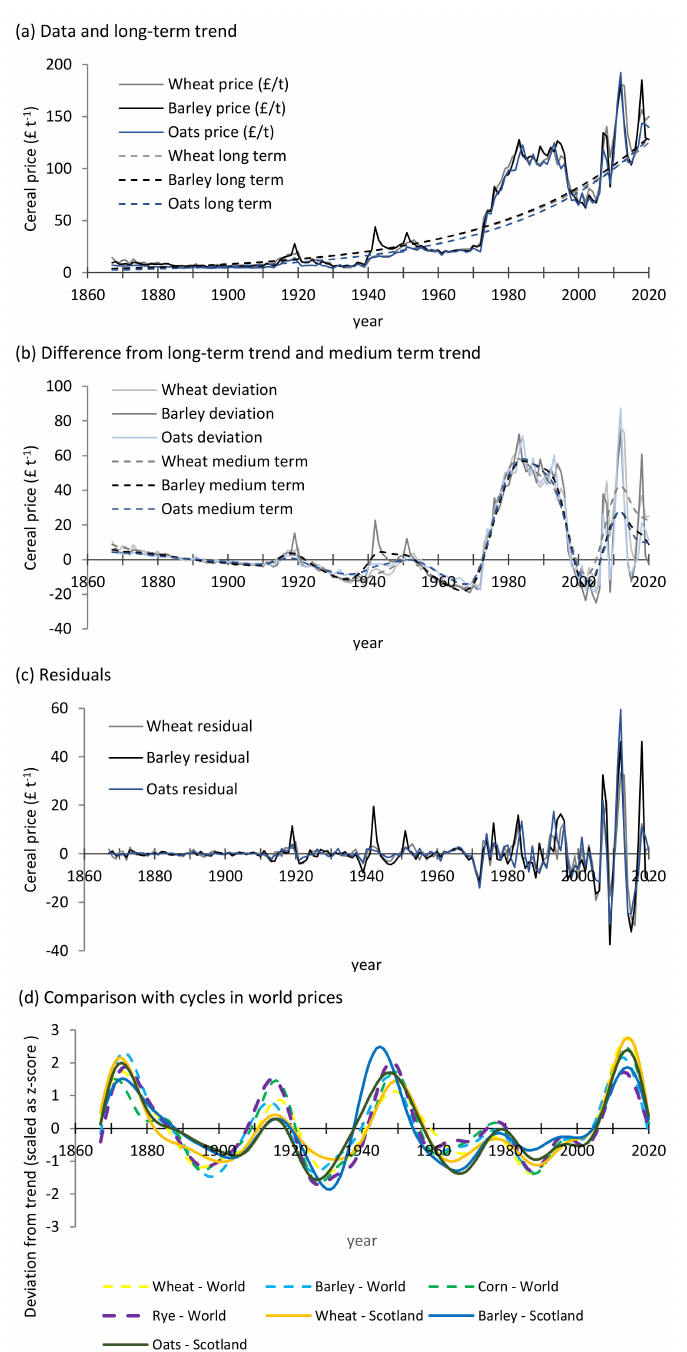
Figure 2. Long-, medium-, and short-term variation in prices for wheat, barley, and oats in Scotland (1867–2020). ( a ) data and long-term trends, ( b ) deviations from the long-term trend and smoothing spline model, ( c ) residuals after removal of the long- and medium-term trends. ( d ) comparison of cycles for prices of wheat, barley, and oats in Scotland with grain crops (wheat, barley, corn, and rye) in world data from Jacks [37,83]. Note: the prices shown in Figure 2a,b, and c are prices for the year. In Figure 2d the cycles comparing prices in Scotland with world prices are based on these prices adjusted for inflation and indexed to a specific year so that they match the indexing for prices for the world dataset used (see Jacks [83]). Price of barley in the year in question, not adjusted for inflation, is used in the analysis of price with other data describing the farming system, since this is the price data available for each individual year when decisions are being made within the farming